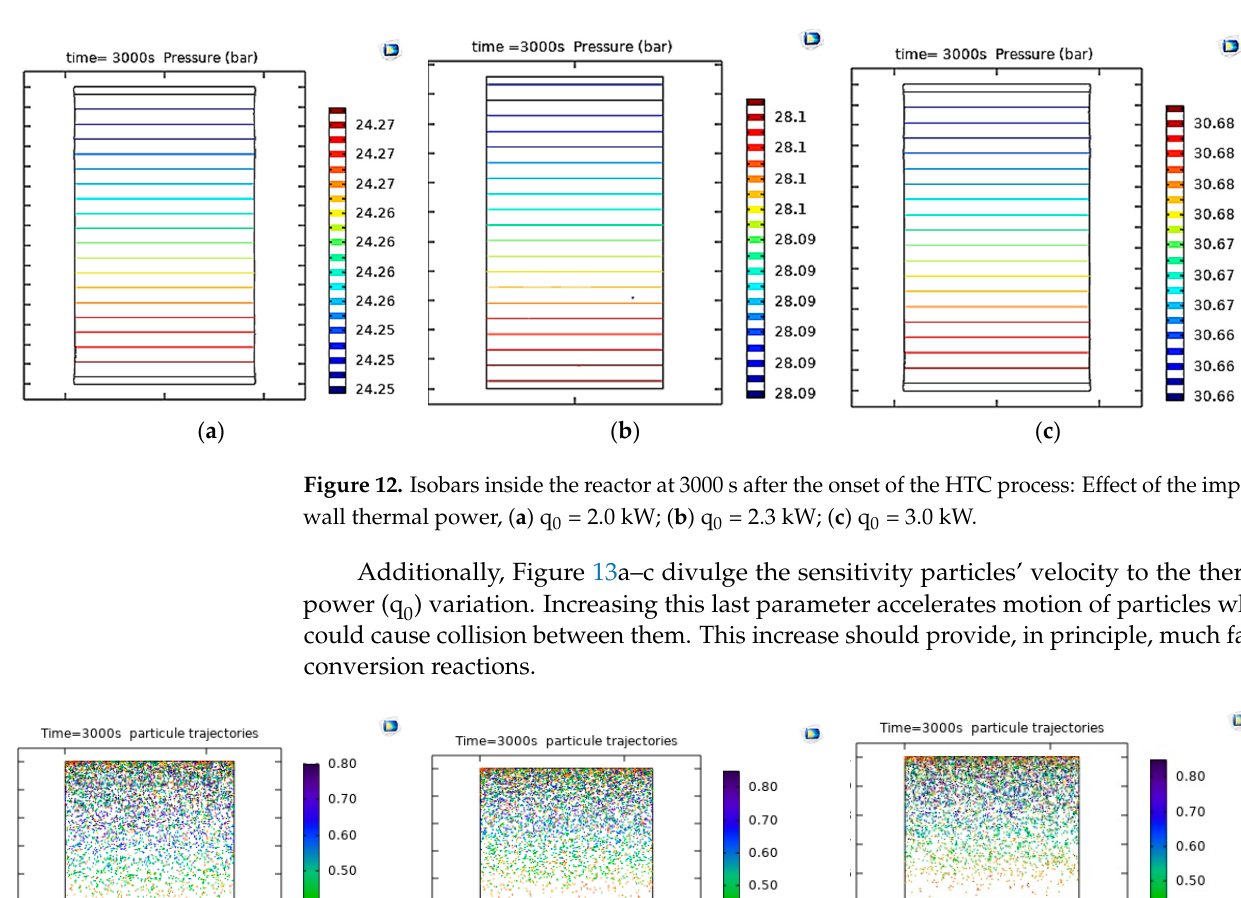
Figure 11. Velocity fields inside the reactor at 3000 s after the onset of the HTC process: Effect of the